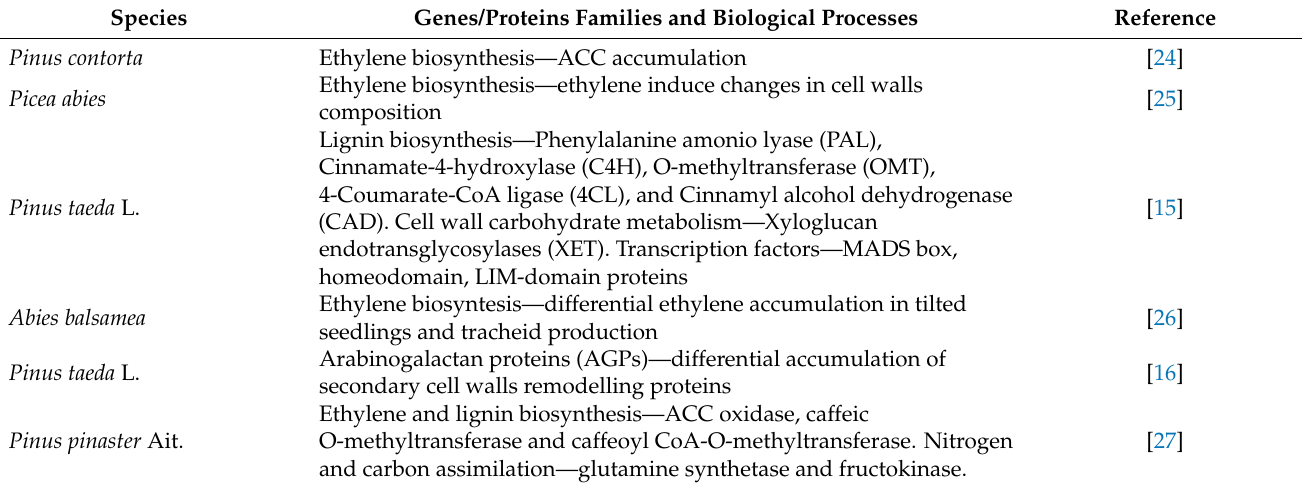
Table 1. Summary of the principal researches about proteins families, biological processes, hormones signaling and biosynthesis, modulated in response to inclination in gymnosperm species.